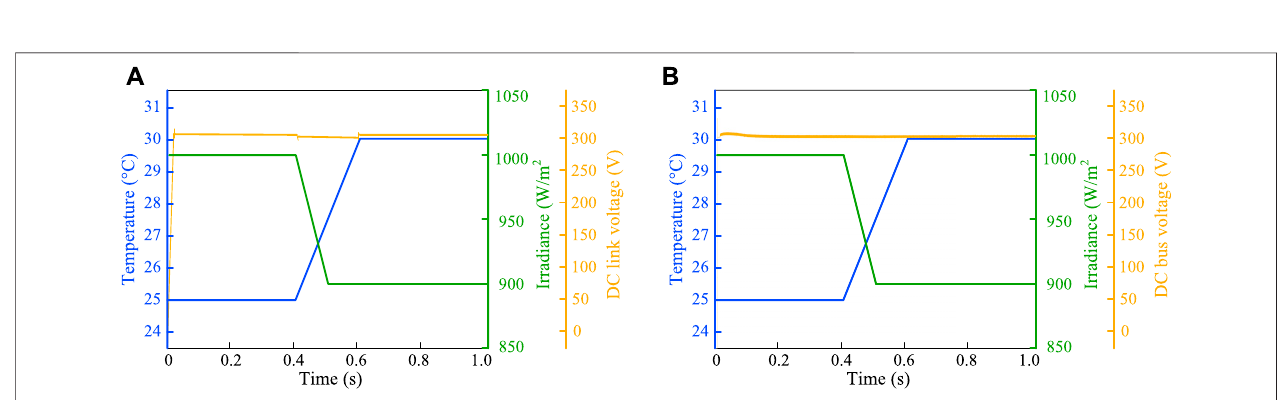
FIGURE 2 | Block diagram of (A) DC bus voltage stabilizer using conventional PI regulator and (B) proposed integral linear-quadratic-Gaussian (ILQG) controller.